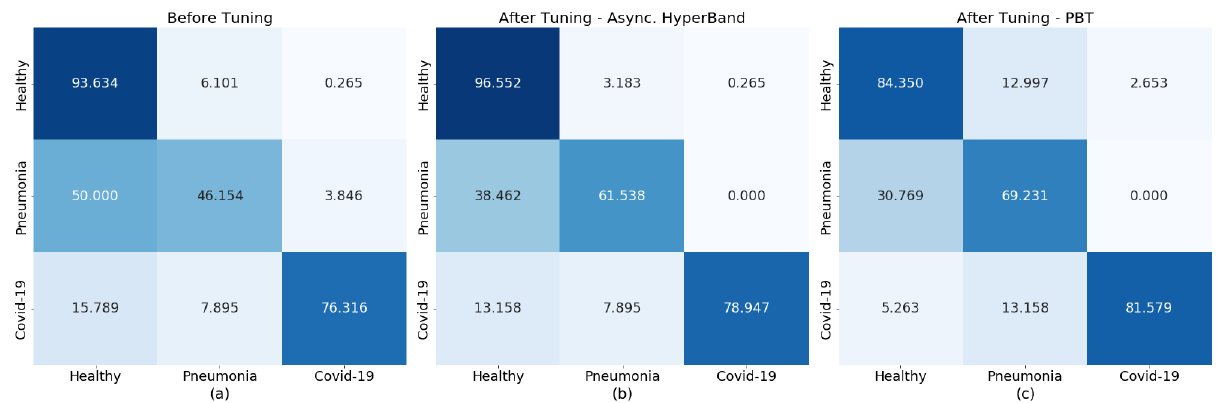
Figure 5. Comparison of trained COVID-Net prediction performance before ( a ) and after hyperpa- rameter tuning with Asynchronous HyperBand ( b ) and PBT ( c